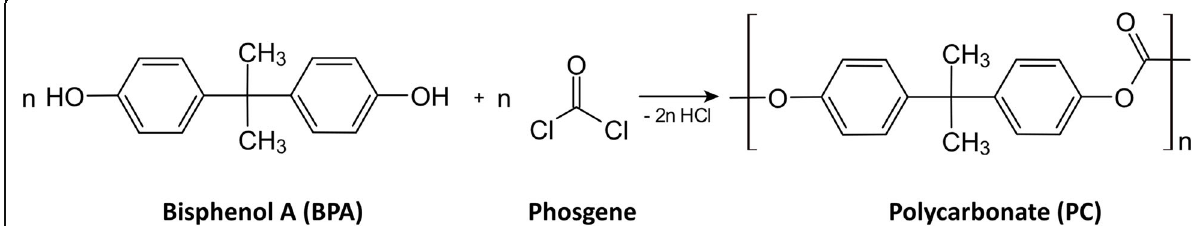
Fig. 1 The industrially favored process for the production of polycarbonate